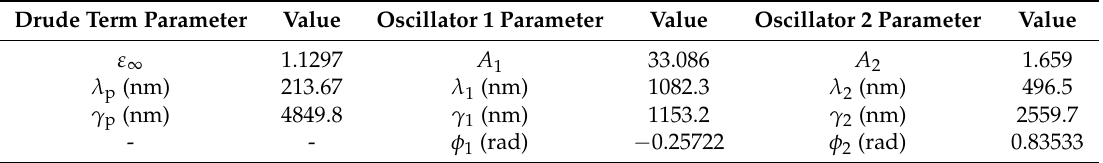
Table 1. Parameters of dielectric function of Cr [16,33].